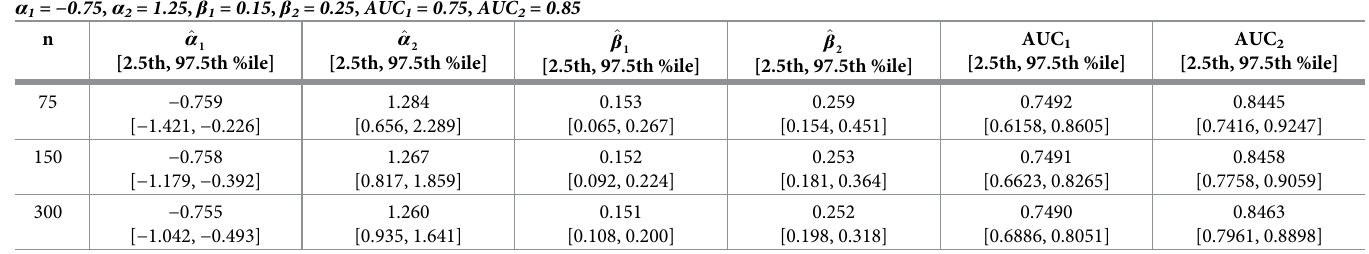
Table 3. Non-proportional odds simulation: NPO1. Parameter estimates and AUCs realized from cumulative ROC curve analysis applied to 10,000 simulated datasets parameterized for non-proportional odds, AUC 1 = 0.75, and AUC 2 = 0.85.